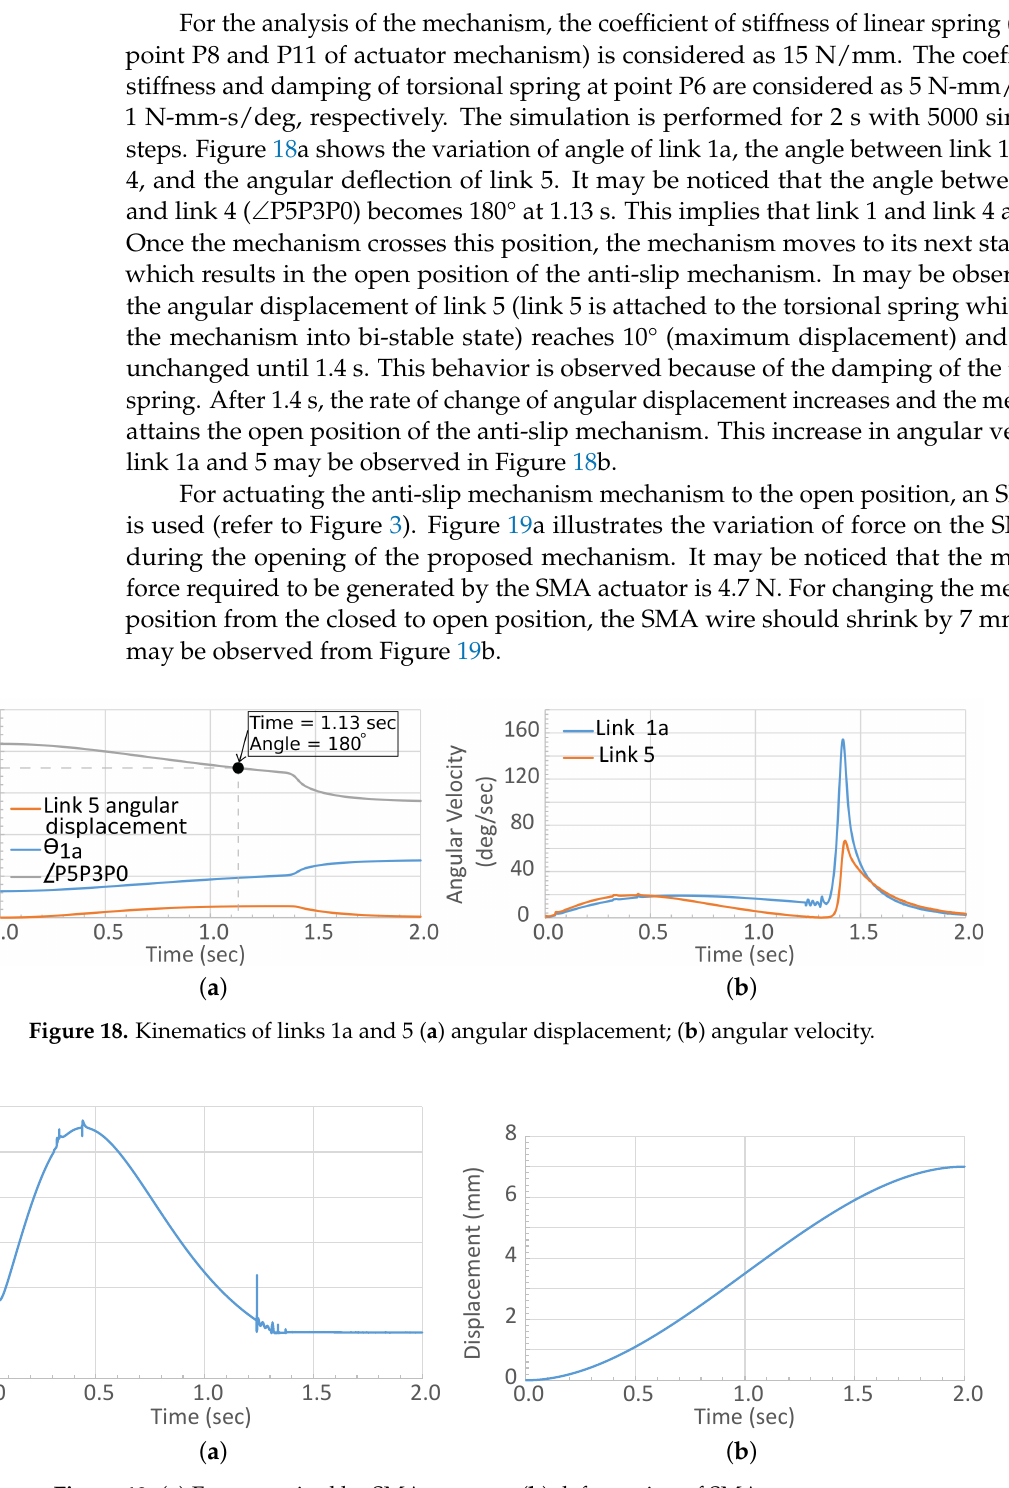
Figure 19. ( a ) Force required by SMA actuator; ( b ) deformation of SMA